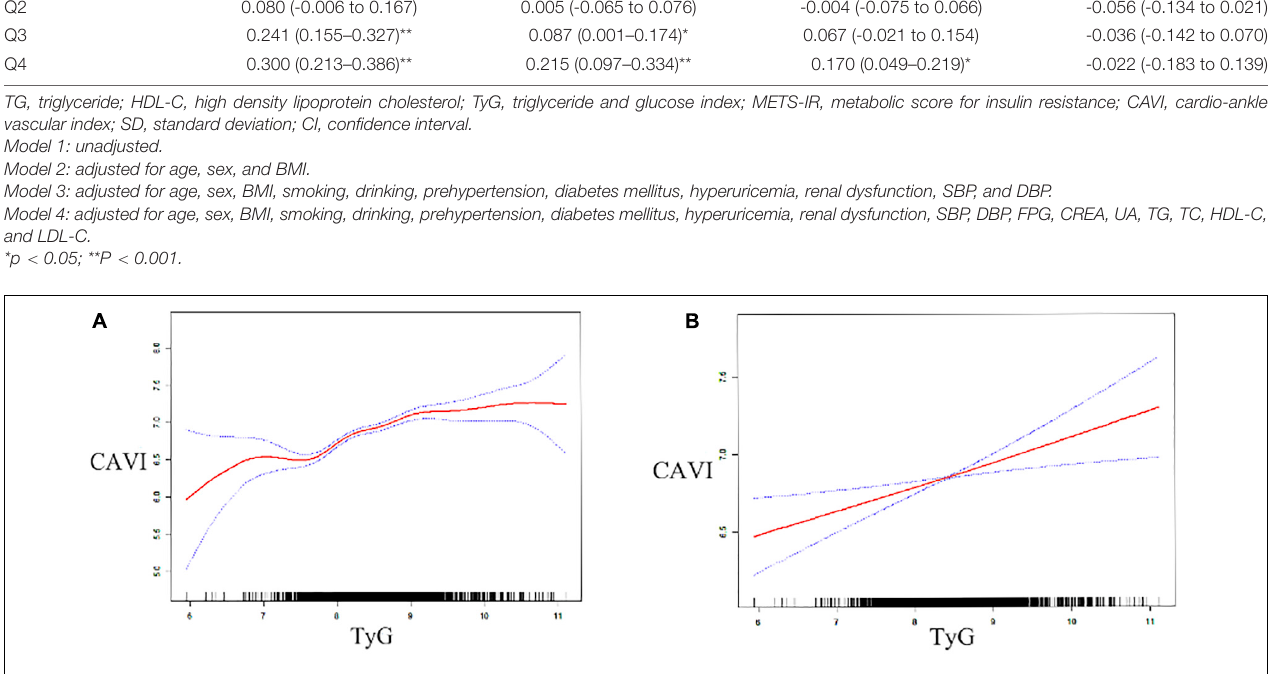
FIGURE 2 | Generalized additive model plot showing the relationship between TyG and CAVI. Data unadjusted (A) and adjusted (B) for age, sex, body mass index, smoking status, alcohol consumption, systolic and diastolic blood pressure, pre-hypertension, diabetes mellitus, hyperuricemia, renal dysfunction, triglycerides, total cholesterol, high-density and low-density lipoprotein cholesterol, fasting plasma glucose, uric acid, and creatinine. CAVI, cardio–ankle vascular index; TyG, fasting triglyceride and glucose